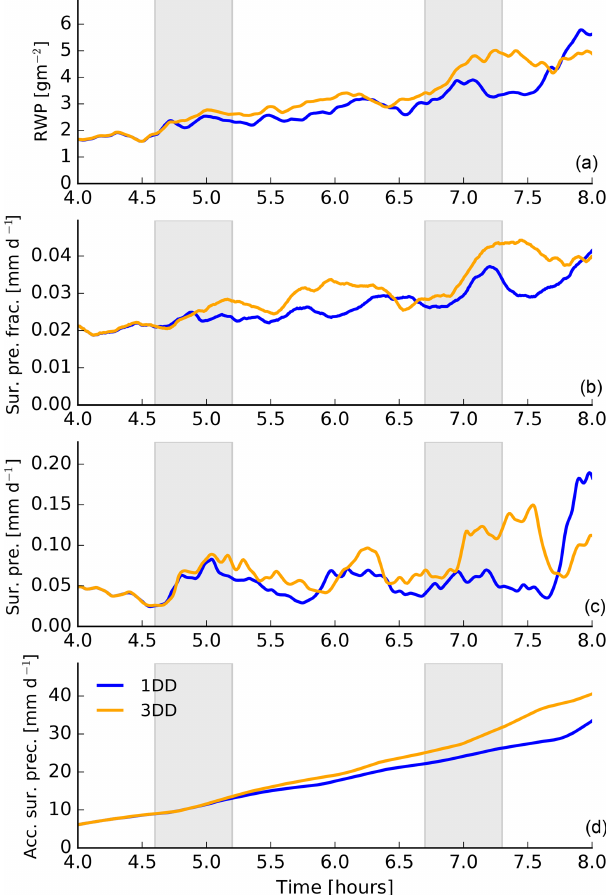
Figure 19. Similar to Fig. 15 but for 1 DD and 3 DD . The gray shaded area shows the time period between 4.6 and 5.3h as well as 6.7 and 7.3h, which are investigated in the further